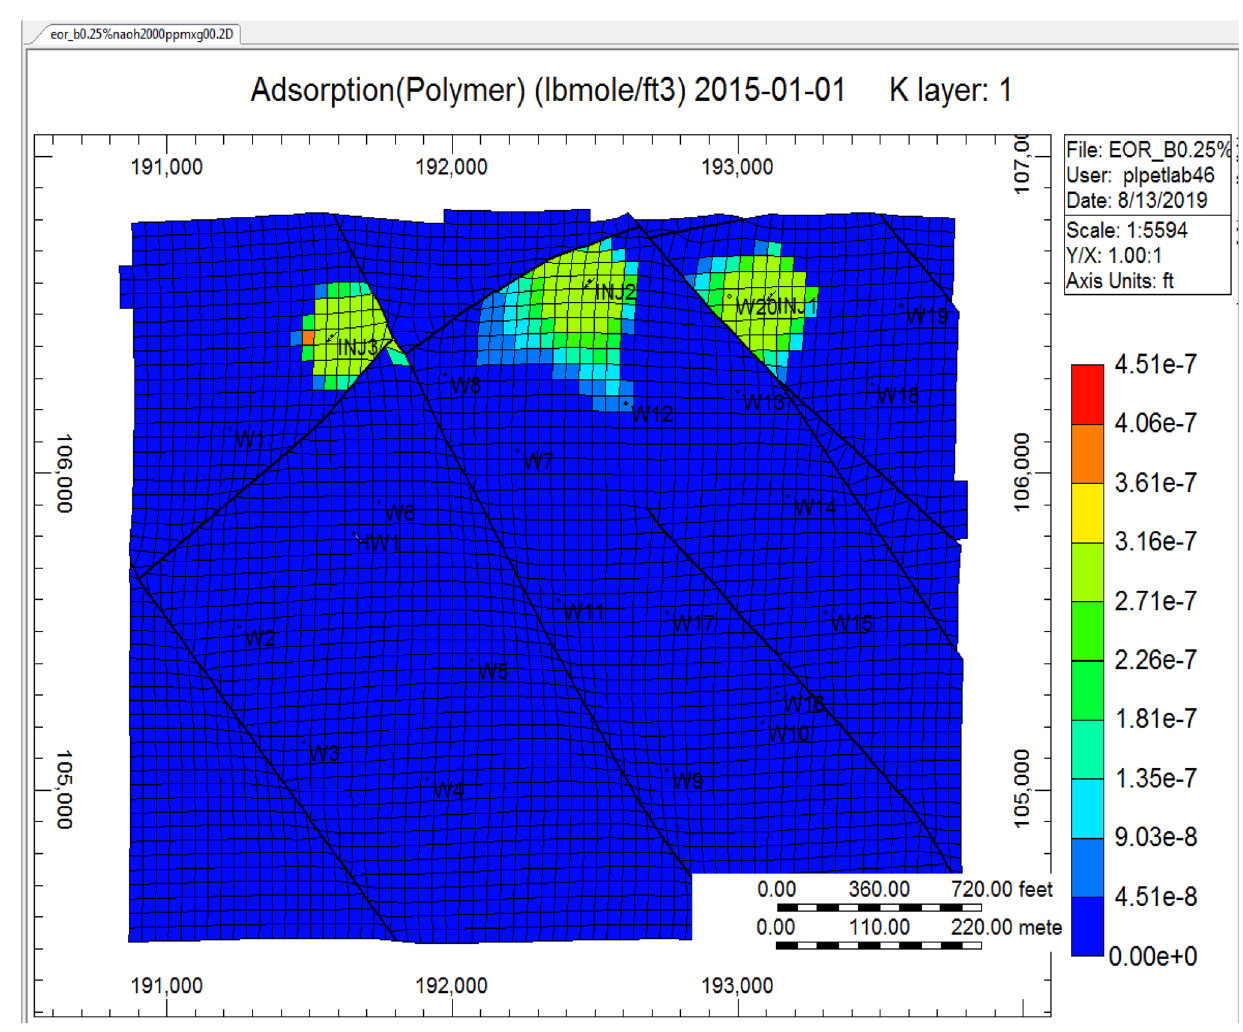
Fig. 12 Adsorption of 2000 ppm Polymer with 0.25%